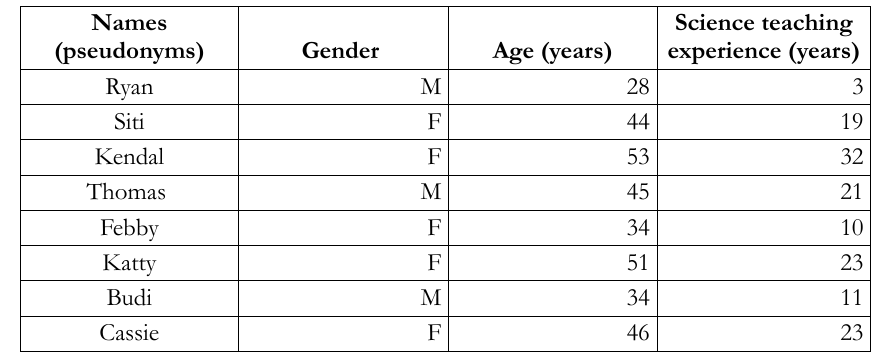
Table 3. Participants in the interview and the